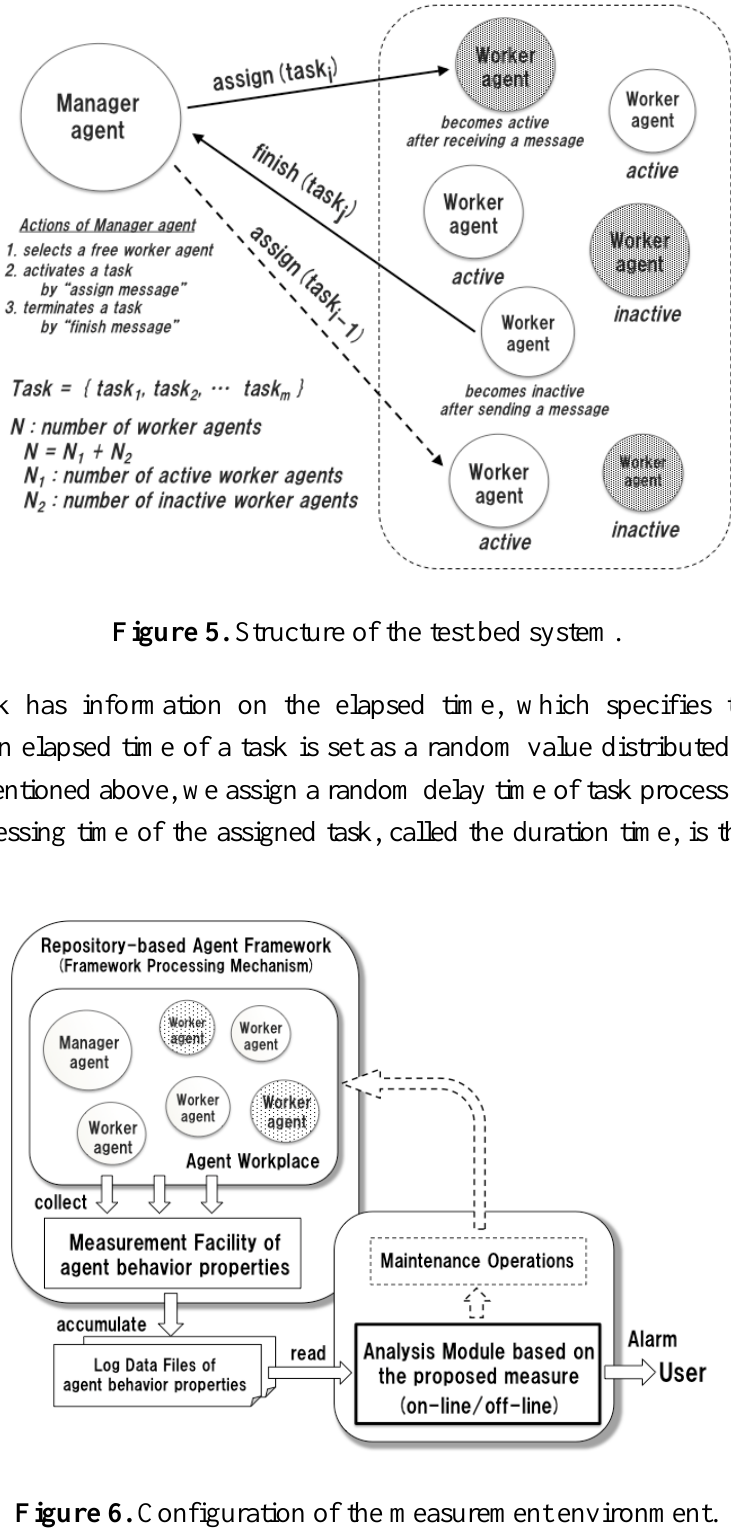
Figure 6. Configuration of the measurement